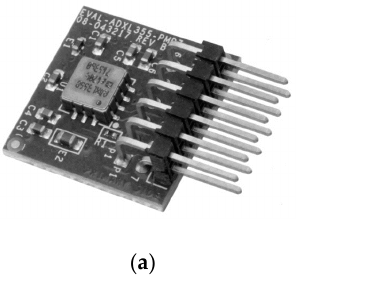
18 Table 4. Root-mean-square error (RMSE) between the proposed and the literature methods [22]. Freq.